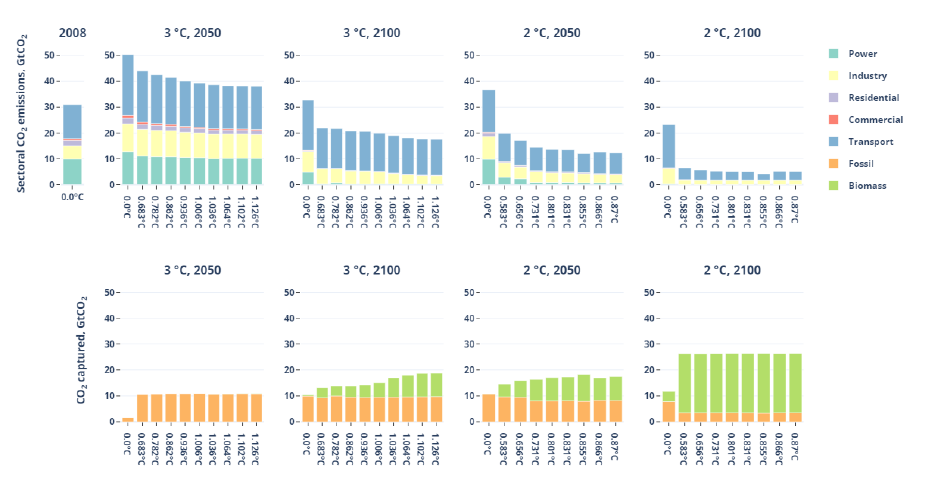
Figure 9. Sectoral emissions and stored carbon (from biomass and fossil